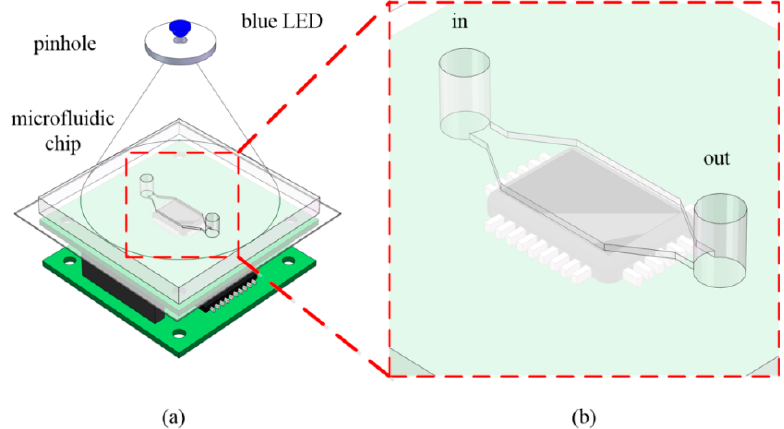
Figure 1. The structure of a lensless imaging system: ( a ) the general structure of the system and ( b ) the observation window of the microfluidic chip.